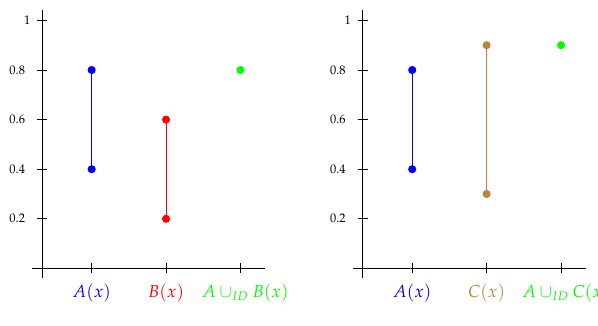
Figure 8. ID -union.